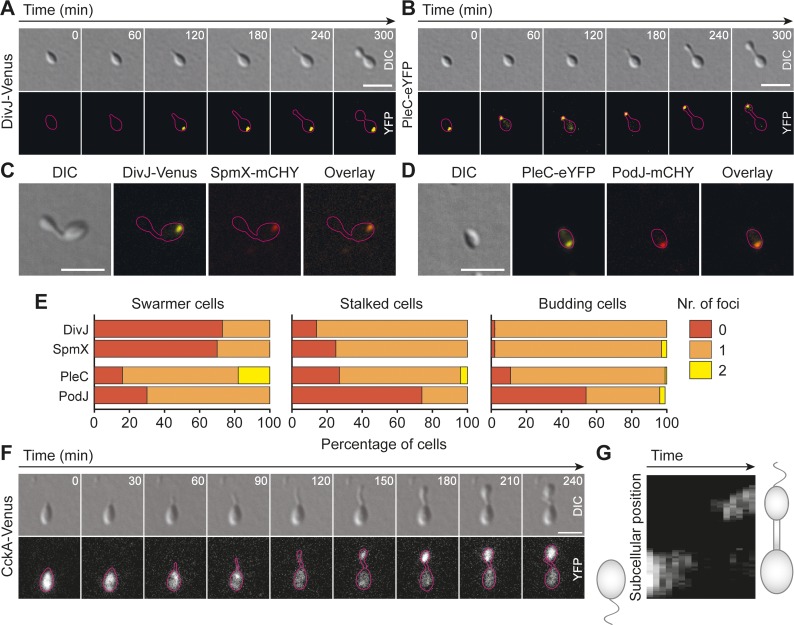
DivJ and PleC mark opposite poles and CckA accumulates in the nascent bud.(A) and (B) Timelapse experiments following H. neptunium cells producing (A) DivJ-Venus (OL146) or (B) PleC-eYFP (OL151) from their respective native promotors. (C) Colocalization of DivJ-Venus (expressed from its native promotor) and SpmX-mCherry (induced by addition of 300 μM CuSO4) (OL32). (D) Colocalization of PleC-eYFP (expressed from its native promotor) and PodJ-mCherry (induced by addition of 300 μM CuSO4) (OL33). (E) Quantification of the number of fluorescent foci in cells imaged as described in panels (C) and (D). For each strain, 100 cells were analyzed per developmental stage. Note that the intensity of the PodJ-mCherry signal was close to the detection limit. Therefore, the counts given for this fusion protein may be an underestimation, explaining the discrepancy in the number of PodJ-mCherry and PleC-eYFP foci. (F) Timelapse experiment following a representative H. neptunium cell expressing CckA-Venus from its native promotor (OL2). (G) Kymograph of the fluorescence signal in the cell depicted in (F). Shown is the maximum signal on a line connecting the two poles and spanning the entire width of the cell. Scale bars: 2 μm.